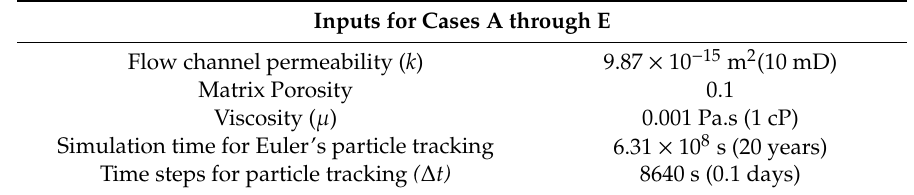
Table A2. Inputs for streamline simulation and pressure gradient calculation.